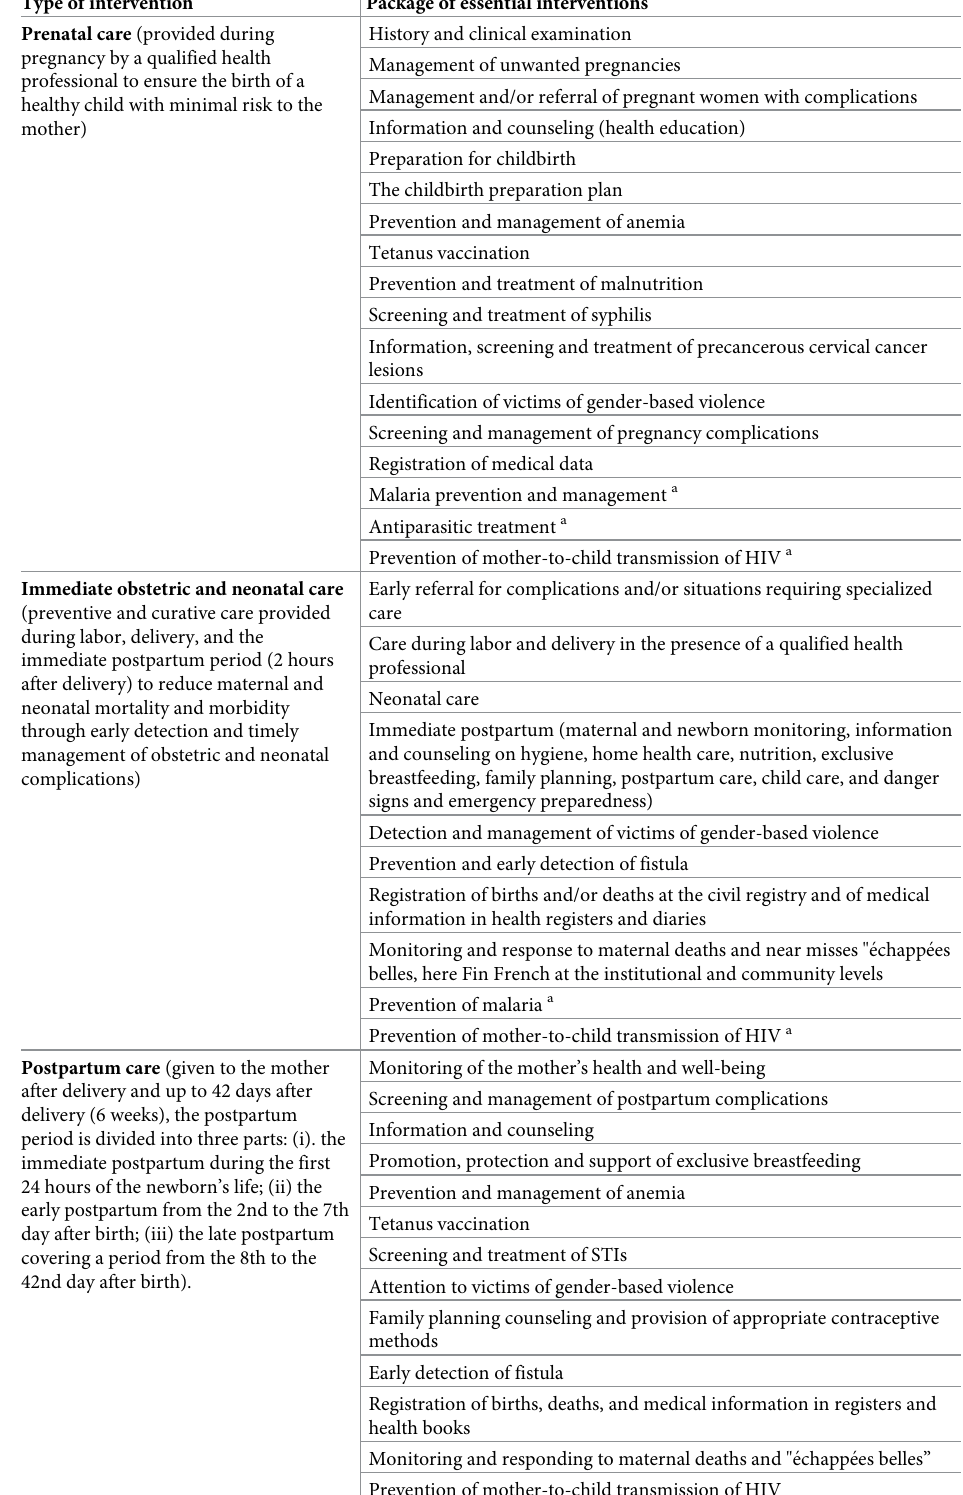
Table 2. Types of intervention / care and related essential intervention